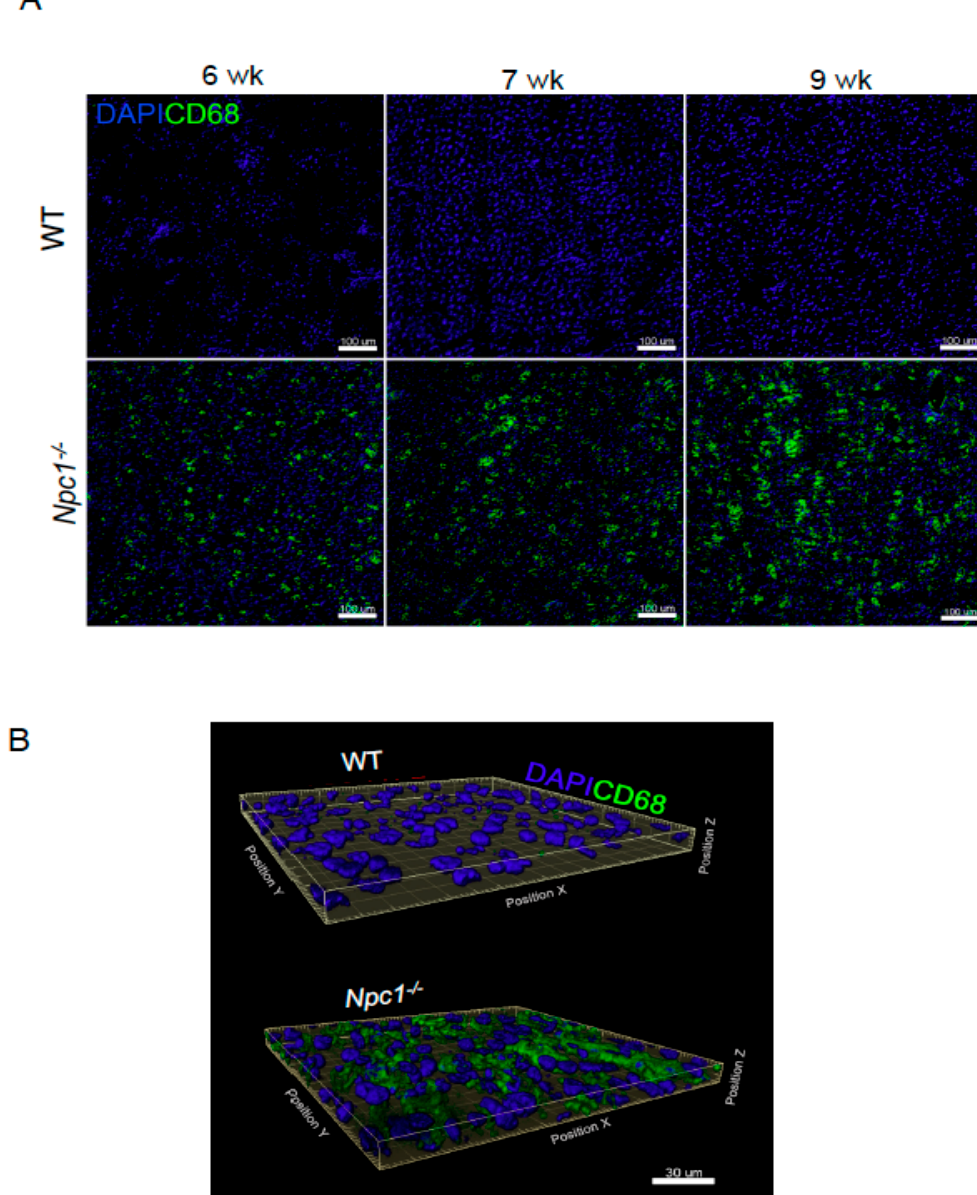
Figure 1. Progressive increase of hepatic CD68 positive cells in Niemann–Pick type C (NPC) mice. ( A ) CD68 staining of livers from 6-, 7-, and 9-week-old (wk) wild-type (WT) and Npc1 − / − mice. Scale bars are 100 µm. ( B ) Three-dimensional reconstructions of liver sections from 9-week-old WT and Npc1 − / − mice.